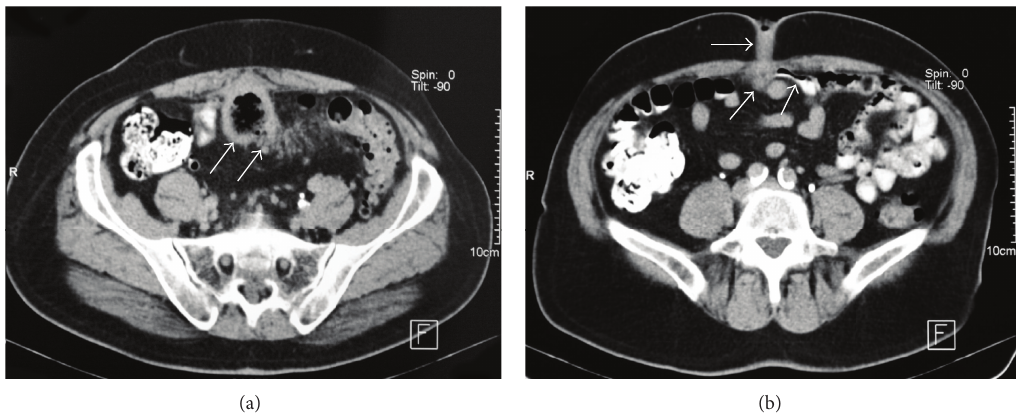
Figure 2: (a) Axial CT scan of the abdomen demonstrating diverticulosis of the sigmoid colon with inflammatory changes in the colonic wall (arrows) and mesenteric stranding with the sigmoid adherent to the posterior aspect of the anterior abdominal wall. (b) A thick-walled cavity (arrows) is present beneath the umbilicus communicating with the sigmoid colon.